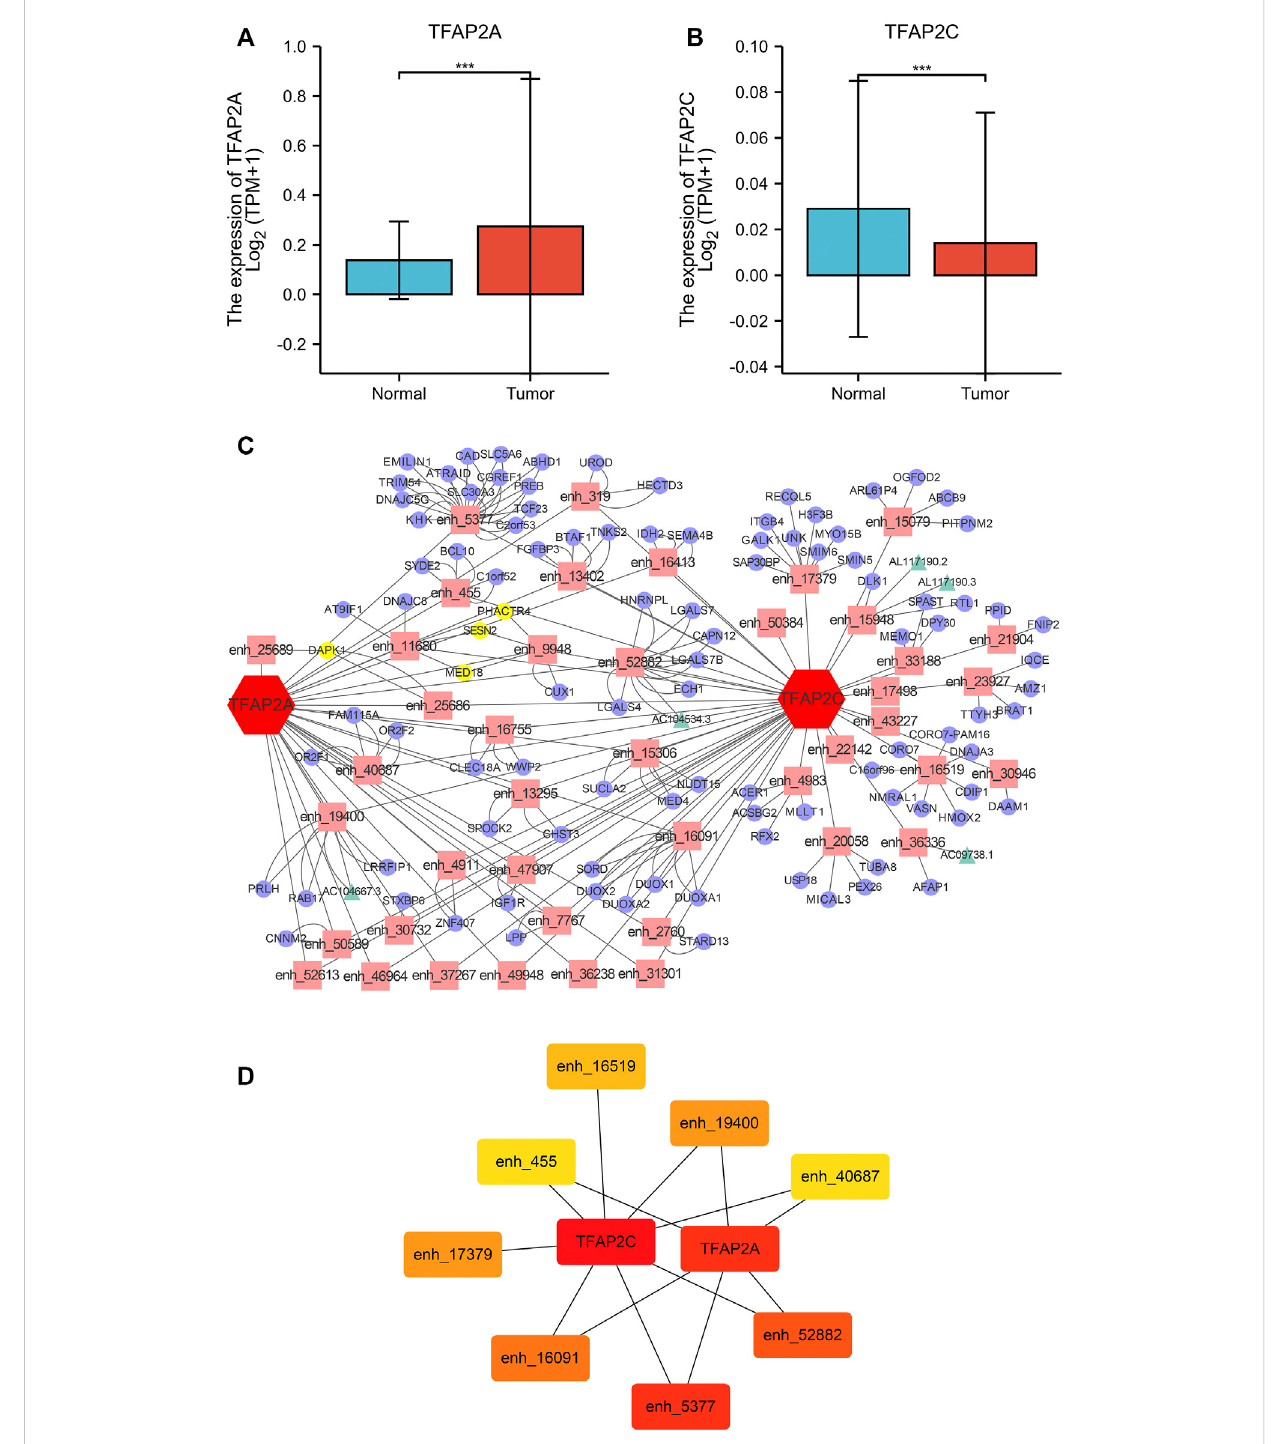
FIGURE 1 TF-Enhancer-Target Regulatory Network in HCC. (A) TFAP2A was signi fi cantly overexpression in HCC tissues. (B) TFAP2C was signi fi cantly downregulated in HCC tissues. (C) The interaction network map of TFs, eRNA associated enhancers, mRNAs and lncRNAs (TFs, red hexagon; enhancers, pink rectangle; mRNAs, purple cycle; lncRNAs, green triangle; co-regulatory targets, yellow node). (D) The heatmap of the hub targets in the regulatory network (* p < 0.05, ** p < 0.01,*** p <